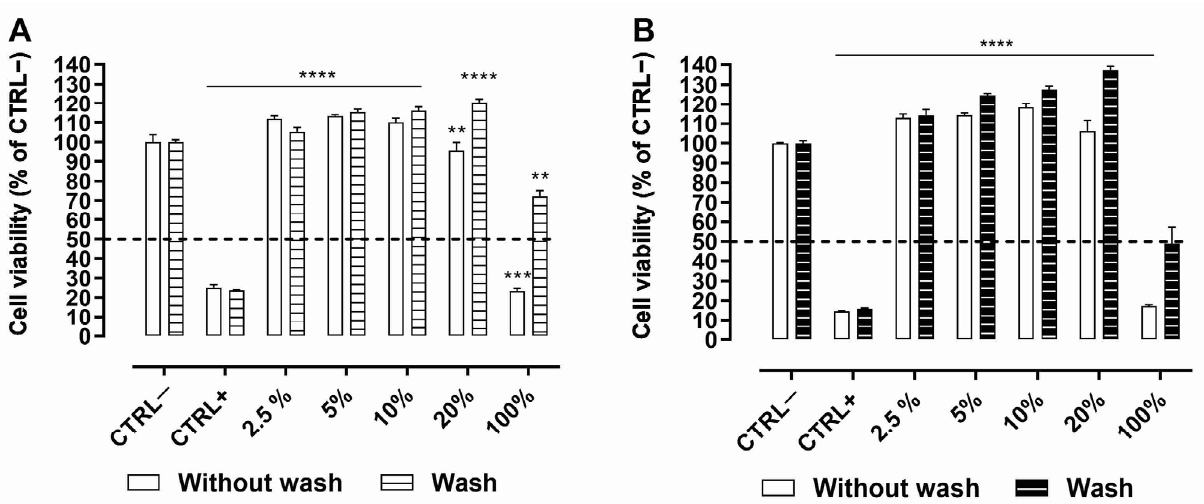
Figure 1. Cell viability of nanostructured microemulsions systems (NaMESys) in Statens Seruminstitut Rabbit Cornea (SIRC) cells by Short Time Repeated Exposure (S.T.R.E.) protocol. SIRC were repeatedly exposed 6 times at 1.5 h intervals between each repeated exposure for 5 min with or without wash to negative control (CTRL − ), 0.01% BAK positive control (CTRL+), undiluted test items (100%) and to different dilutions of the same test items corresponding to 20%, 10%, 5% and 2.5% concentrations of ( A ) control formulation (NaMESys) or ( B ) microemulsion carrying sorafenib tosylate 0.3% (NaMESys-SOR). A dotted line placed at 50% represents the cut-off value to determine cytotoxicity potential according to ECVAM protocol DB-ALM n° 17. Data are presented as mean ± S.E.M. of two independent experiments performed in triplicate. ** p ≤ 0.01, *** p ≤ 0.001 and **** p ≤ 0.0001 vs. cut-off at 50%.